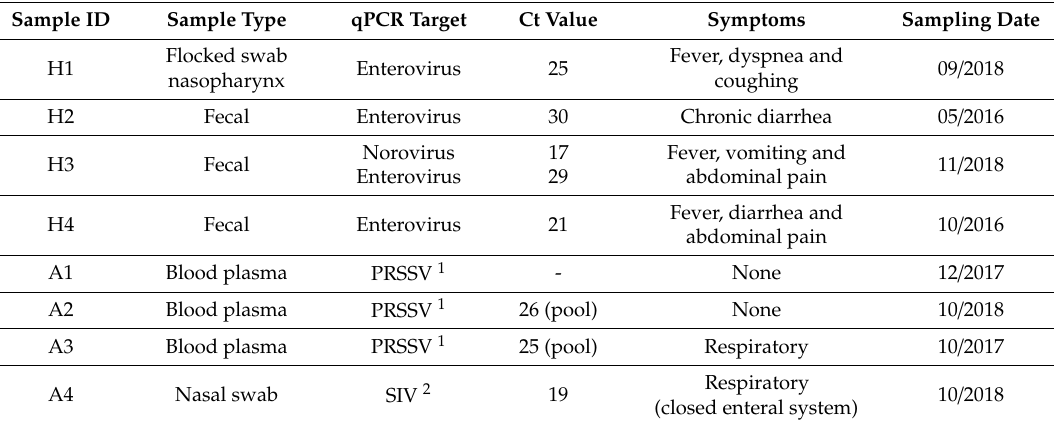
Table 1. Description of human and animal sample